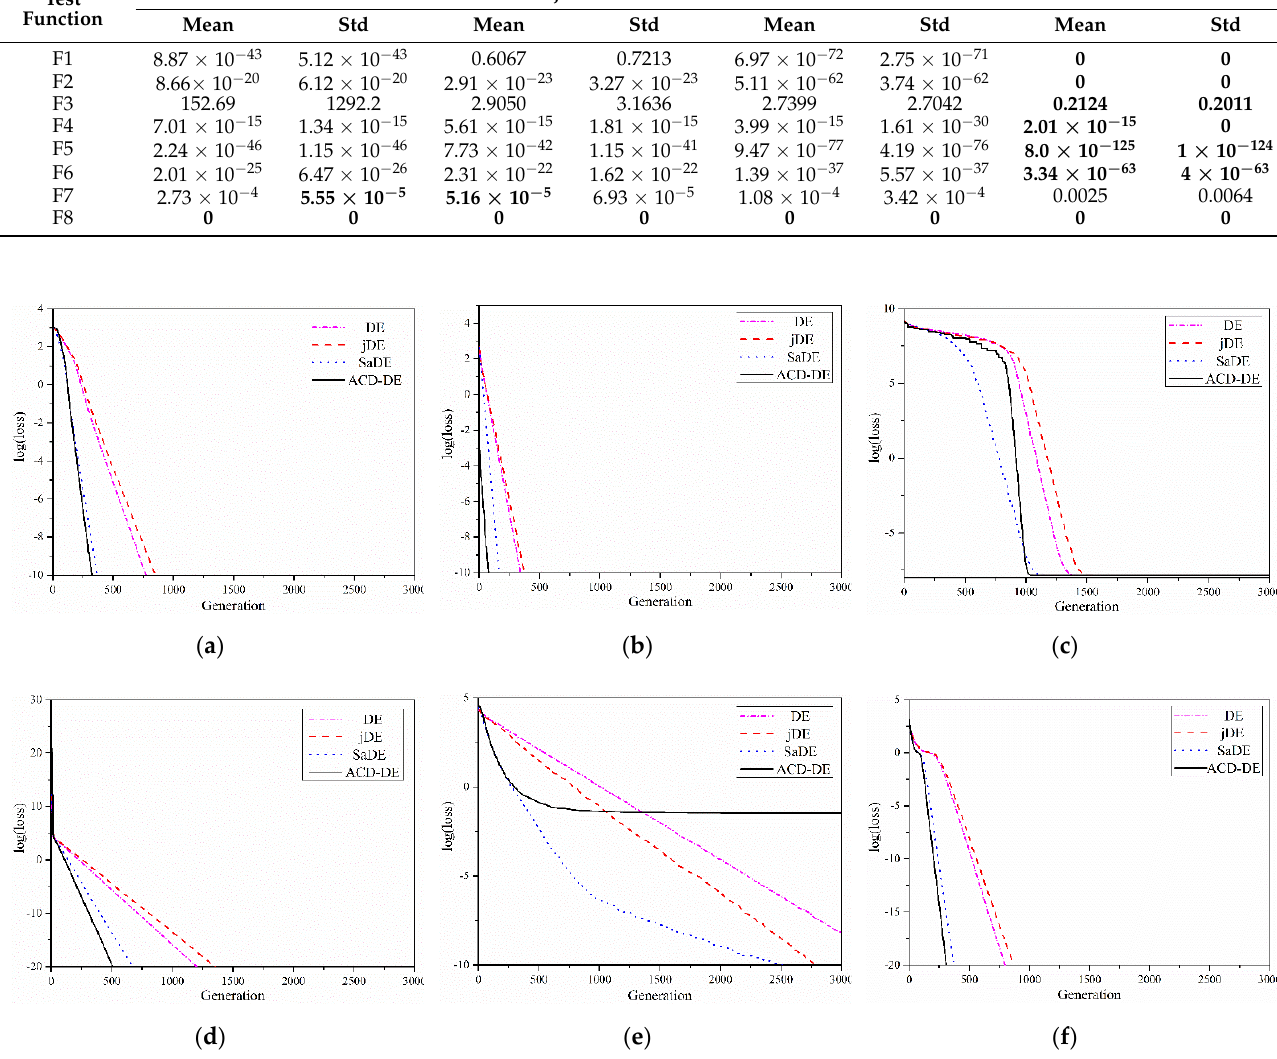
Figure 5. Median convergence characteristics of DE, jDE, SaDE, and ACD − DE on test functions. ( a ) Convergence curve of F3; ( b ) convergence curve of F4; ( c ) convergence curve of F5; ( d ) convergence curve of F6; ( e ) convergence curve of F7; ( f ) convergence curve of F8.